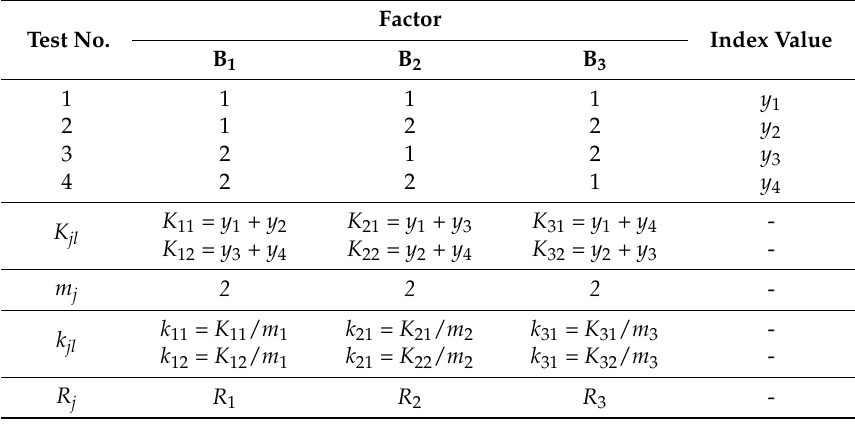
Table 1. Analysis of the orthogonal test result.